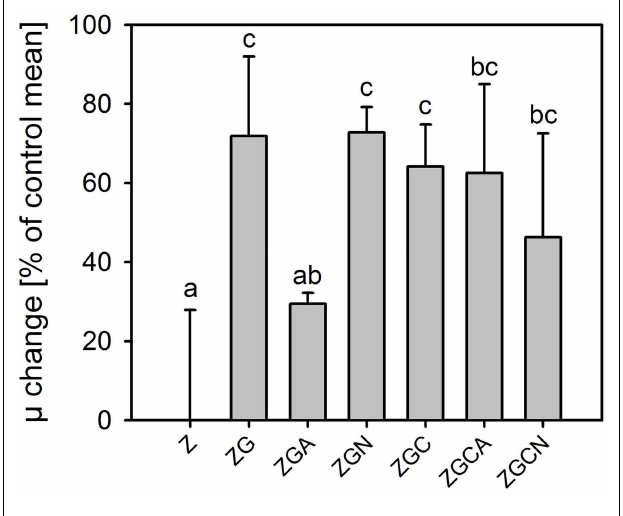
FIGURE 3 | Change in relative growth rates (mean ± SD, n = 6) of Chlorella mirabilis under different nutrient treatments in the in-door micro-scale mass cultivation experiment (seeTable 1 for treatment abbreviations) .The values were normalized to control mean (100%).The zero line corresponds to 100% of the control.The same letter indicates homologous groups as recognized by theTukey HSD test at p = 0.05; the Z medium (control) is included in the group labeled